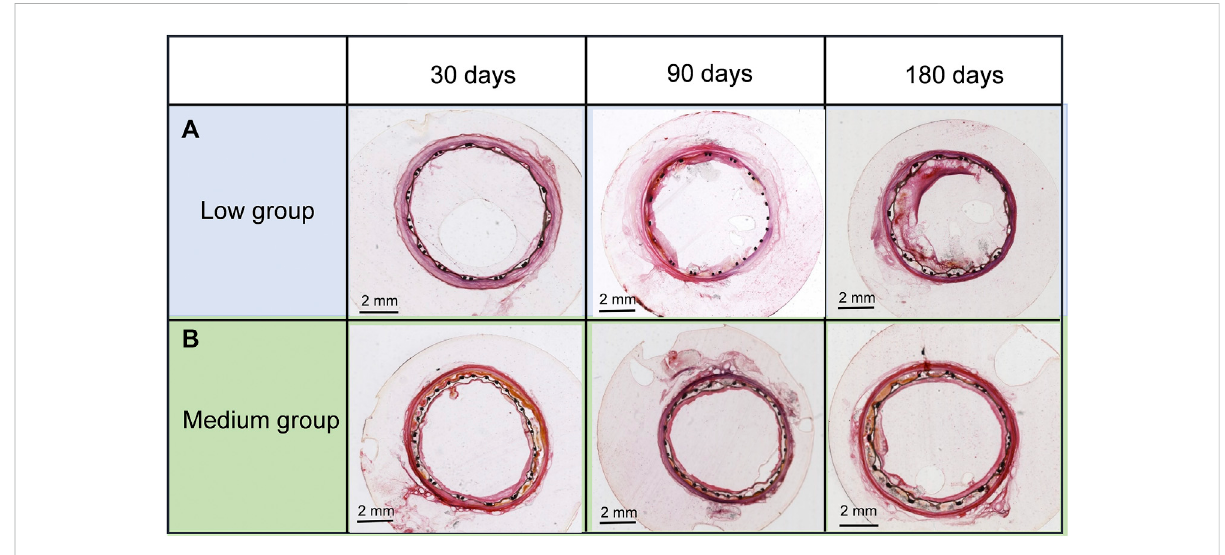
FIGURE 5 Cross-sectionsof (A) thelow-and (B) medium-thicknessePTFE-stentgraftsat30,90,and180 days.Specimenswerestainedwithhematoxylin and eosin.